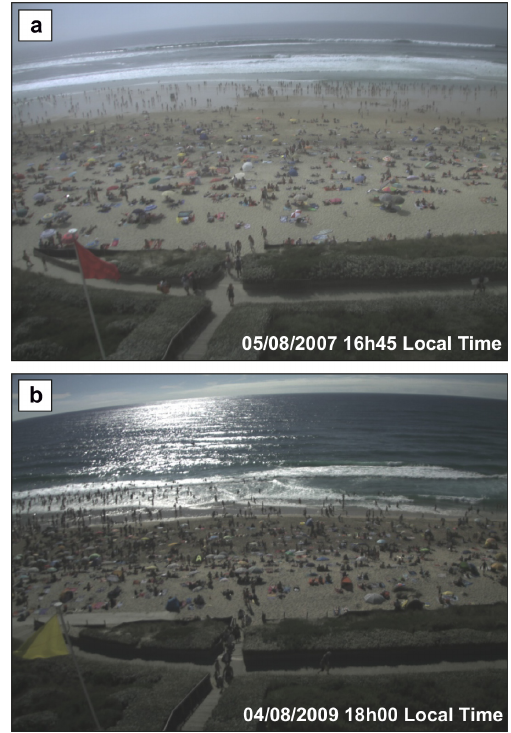
Figure 6. Snapshots of Biscarrosse beach from a video station (Angnuureng et al., 2017) during the days with the largest num- ber of SZIs related to (a) rips on 5 August 2007 and (b) shore-break waves on 4 August 2009, with pictures taken approximately at the time of the most hazardous conditions (Figs. 7; 10). Note that in panel (a) the red flag is hoisted meaning that bathing was forbidden all along the beach due to the presence of